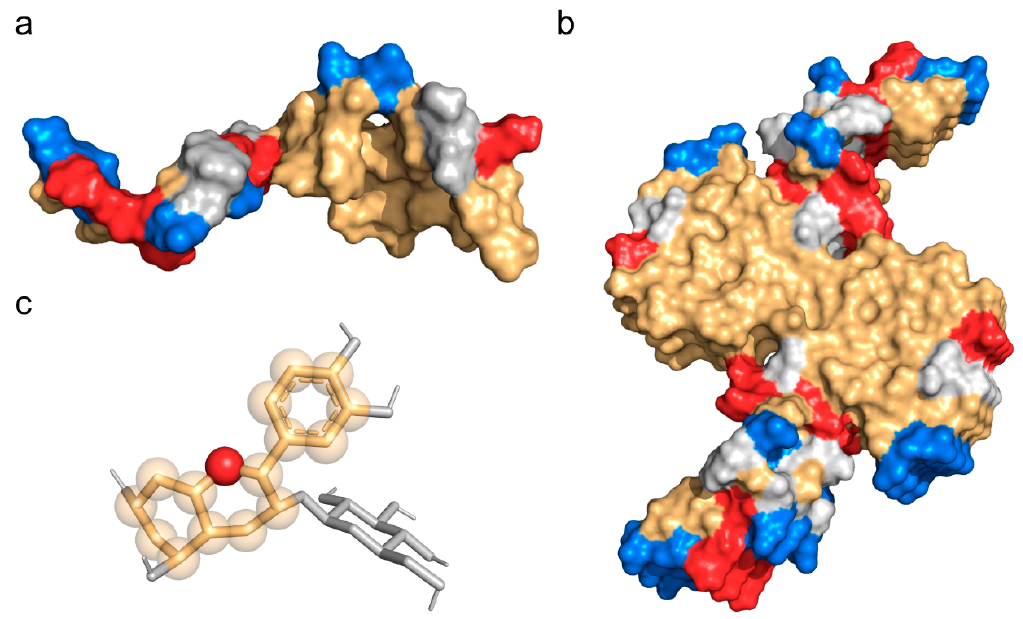
Figure 1. Structure of Cy-3G and different A β polymorph. ( a ) Space-filling model of a simulated, single A β peptide solution structure. Positive and negative charges on the proteins are shown in tv_red and marine, respectively. The hydrophobic part is shown in light orange. ( b ) Space-filling model of a disease-relevant A β fibril structure. ( c ) Space-filling model of Cy-3G showing the positive charge (tv_red) and the hydrophobic character (light orange) on the 2-phenylbenzopyrylium core of this molecule.